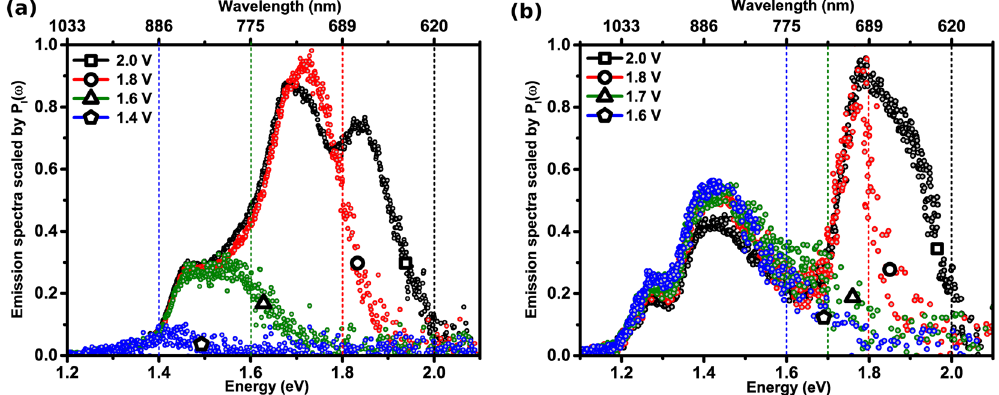
Figure 6. ( a , b ) Light emission spectra at various biases, scaled with the corresponding tunnel current power spectral density.